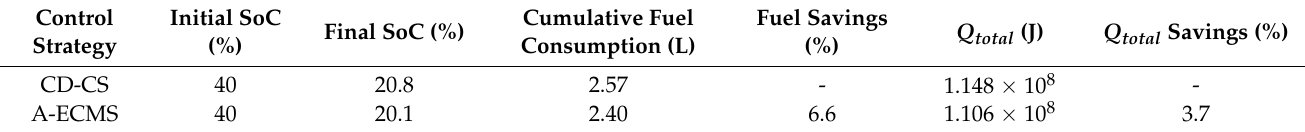
Figure 12. Vehicle performance comparison for WLTC cycles. Table 5. Summary of the vehicle performance comparison for WLTC